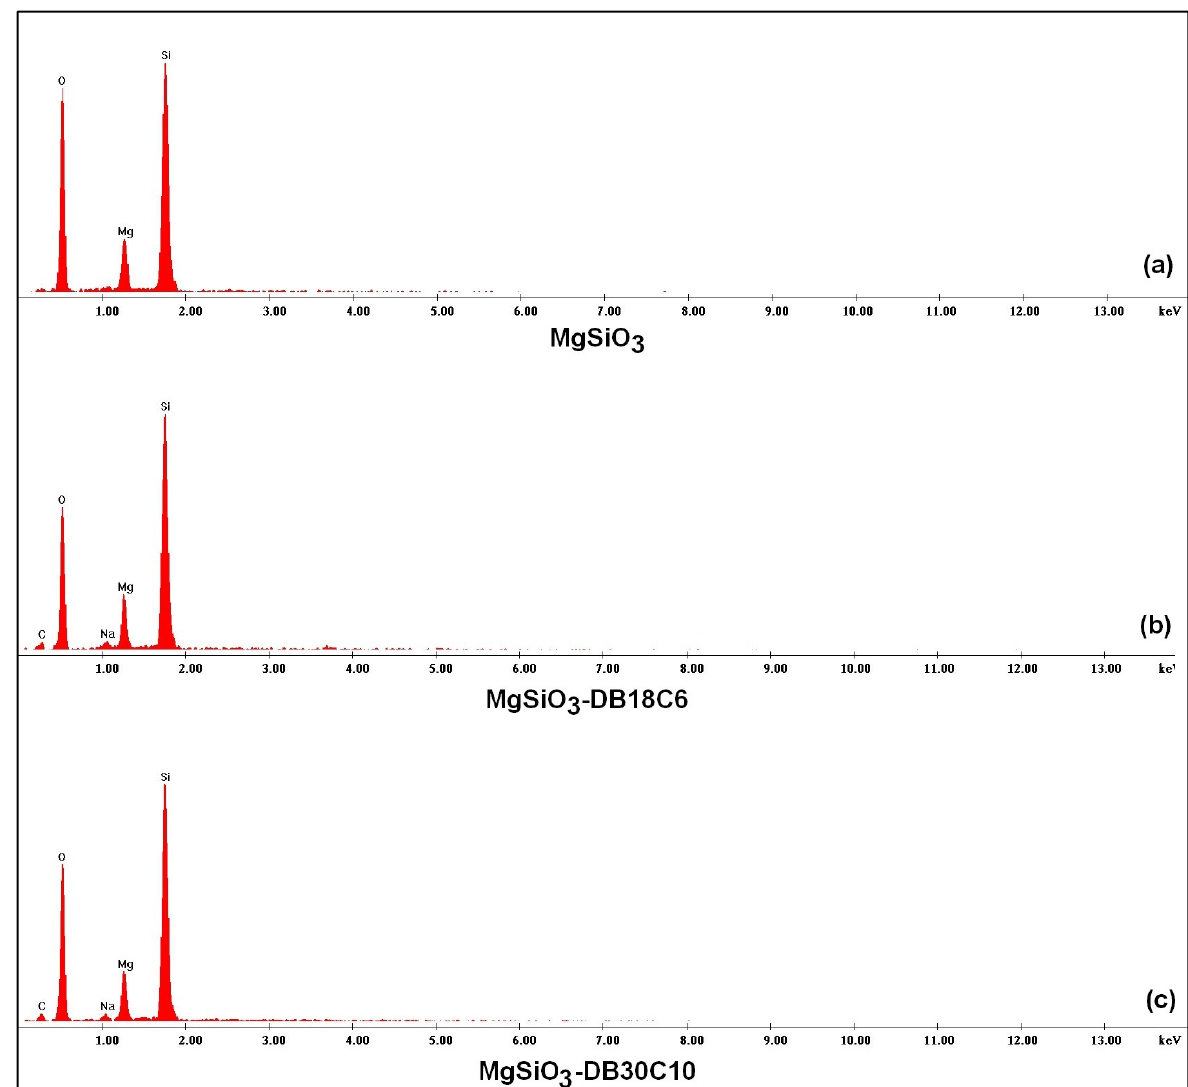
Figure 2. EDX spectroscopy of the adsorbent before and after functionalization: ( a ) MgSiO 3 , ( b ) MgSiO 3 -DB18C6 and ( c ) MgSiO 3 -DB30C10.